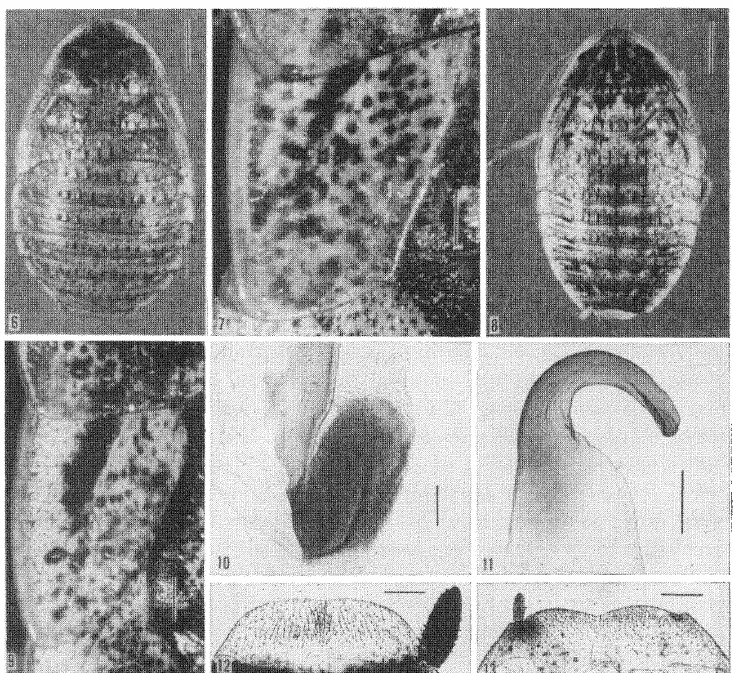
Figures 6-13. Calolampra darlingtoni. 6. 9 (136 MCZ), paratype. .Alaga,te, Mt. Lofty Range, S. A. 7. ’regmen ot 9 shown in figure 6.